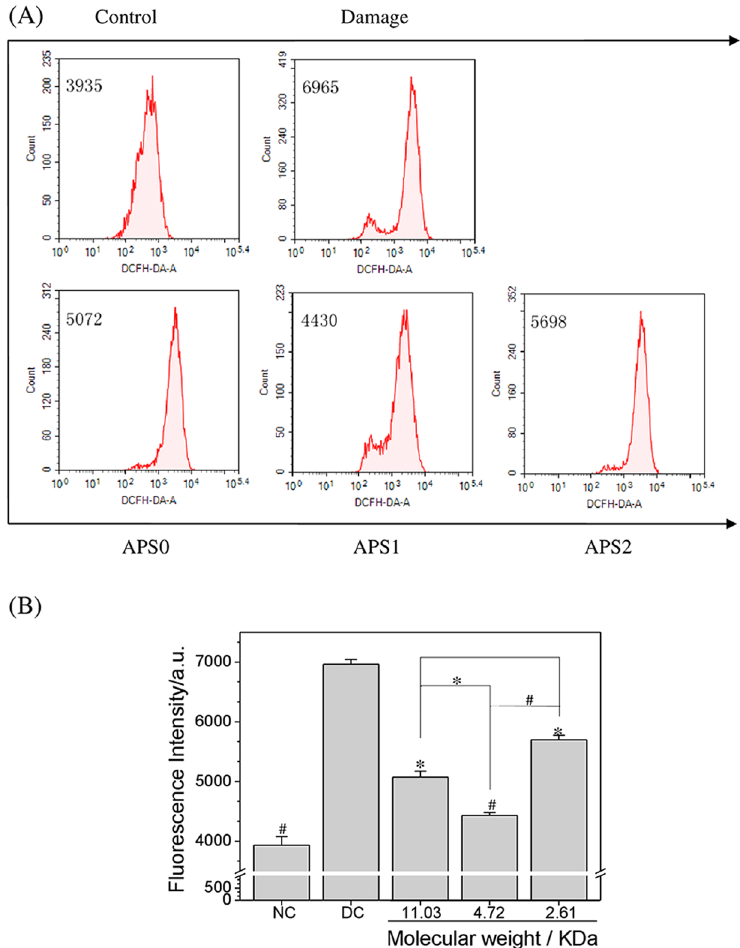
Figure 4. Changes in ROS level of 2.6 mM oxalate damaged HK-2 cells after repair by different Mw APS (60 μ g/mL) for 10 h. ( A ) Histogram of intracellular ROS; ( B ) quantitative results of intracellular ROS. Compared with DC group, * P < 0.05; # P <